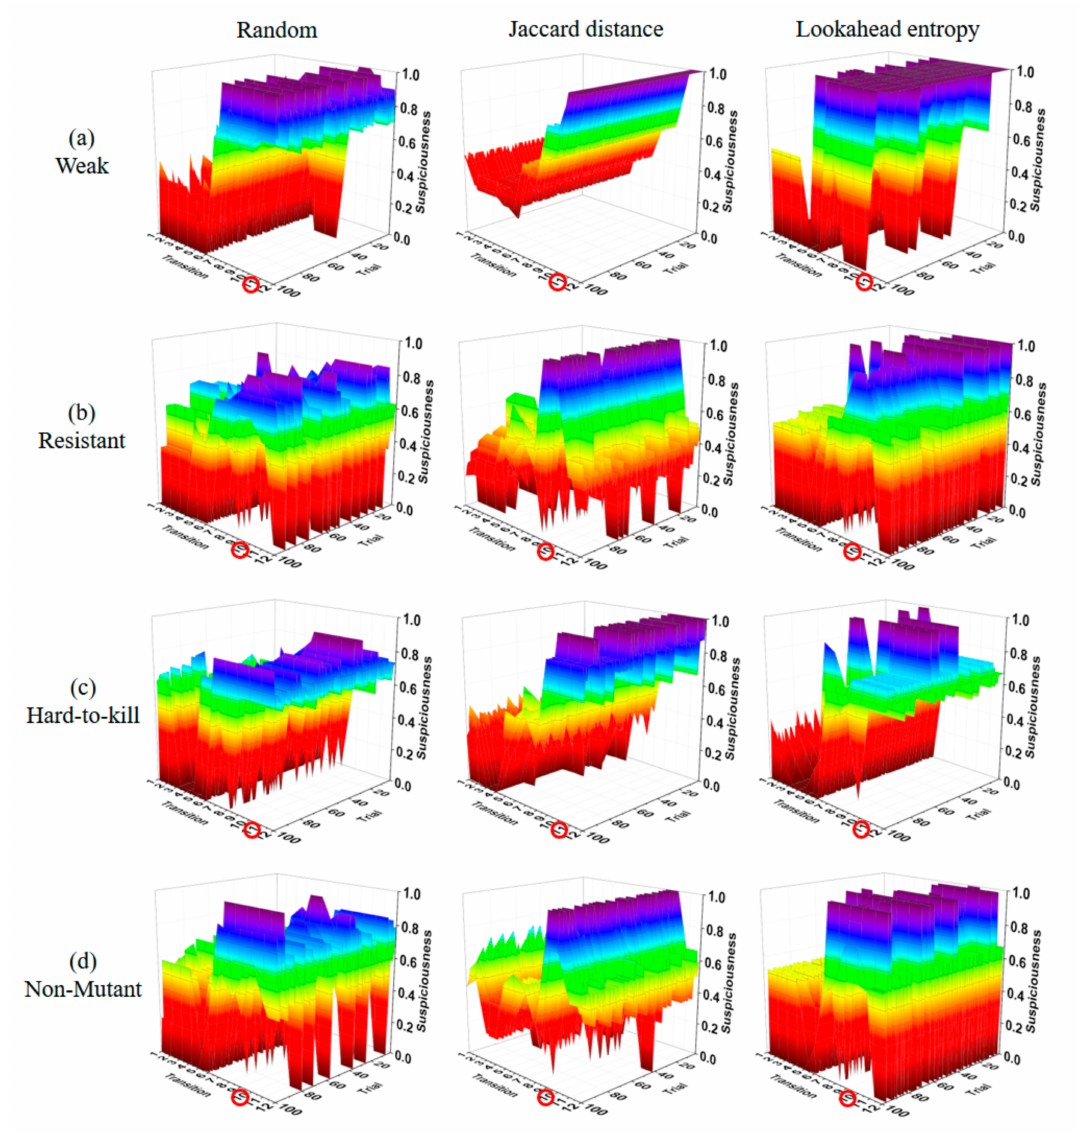
Figure 14. Suspiciousness of the whole transition (tree state